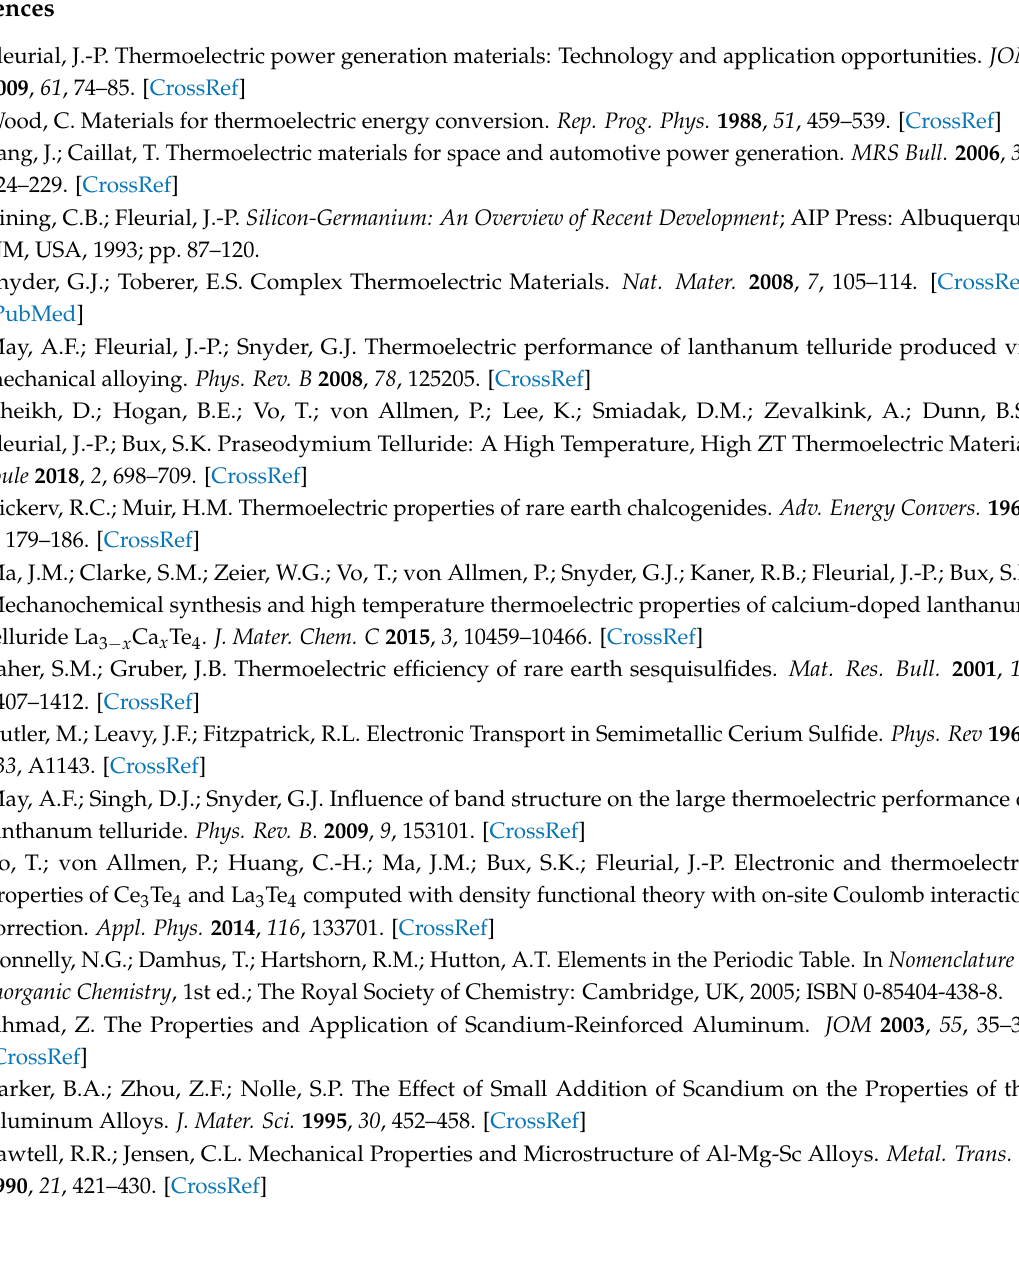
Figure S1. Temperature-dependent heat capacity. Table S1. Sample density